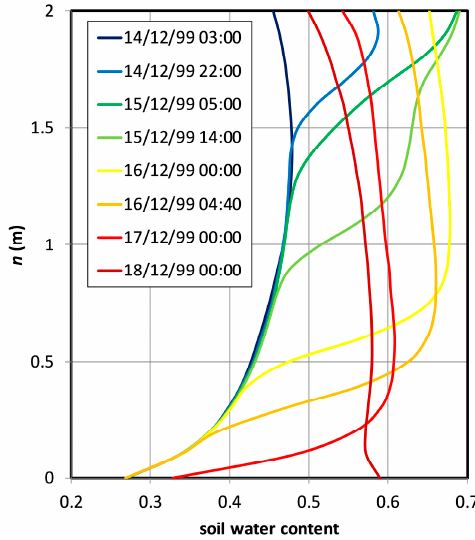
Figure 7. Simulated soil water content profiles throughout the soil cover (calculated at s = 150 m as representative of most of the slope length) between 14–18 December 1999.